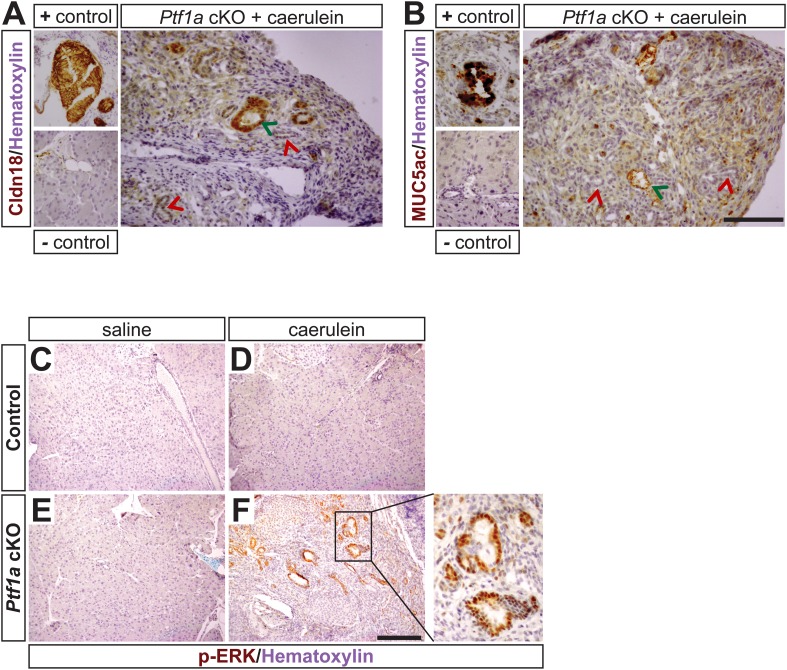
Mucinous metaplasia associated with hyperactive MEK-ERK signaling in caerulein-treated Ptf1a cKO pancreata.(A, B) IHC for the PanIN markers Claudin-18 (A) and MUC5ac (B) in caerulein-treated Ptf1a cKO with corresponding positive and negative controls. Green arrows indicate weakly Claudin-18 positive or Muc5ac positive lesions and red arrows indicate Claudin-18/Muc5ac negative metaplasia. (C–F) IHC for phosphorylated-ERK (p-ERK) on control and Ptf1a cKO pancreata 1 week following caerulein treatment. Enlarged boxed area highlights mucinous metaplasia-like lesions from caerulein-treated Ptf1a cKO pancreata with strong nuclear p-ERK signal. Scale bars: 200 μm.